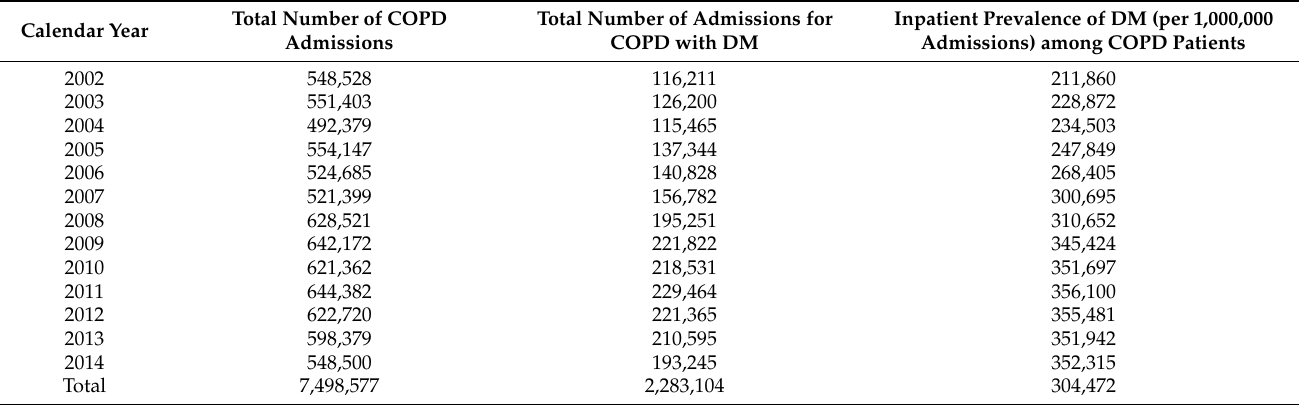
Table 2. Trends of hospitalization for chronic obstructive pulmonary disease and diabetes mellitus in COPD 2005–2014. Total Number of COPD Calendar Year